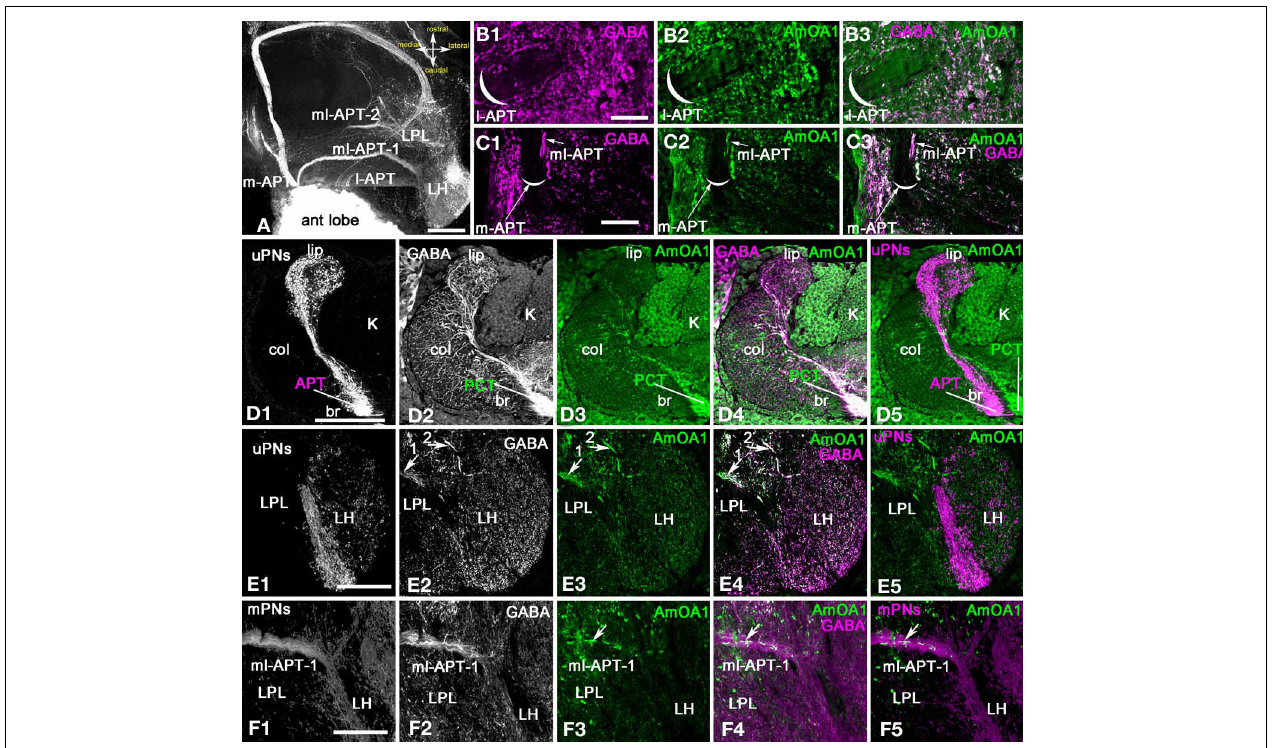
FIGURE 4 | Apis mellifera : The AmOA1 immunostainings in the central brain neuropils (LPL, PL, and MB calyx) are co-localized in the GABAergic neurons but not in uPNs. (A) An injection of a neurobiotin tracer into the antennal lobe revealed all antenna-protocerebral tracts (APTs). (B) The origin of l-APT tracts did not show GABA (magenta, B1 ) and AmOA1 (green, B2 ) staining inside of the tract. (B3) The merged image shows white fibers indicating the co-localization of anti-GABA and Anti-AmOA1 in the area surrounded the l-APT. (C) The beginning of the m-APT in a frontal section of the brain in which the anti-GABA ( C1 , magenta) and anti-AmOA1 ( C2 , green) are co-localized in the lateral part of the tract (white image merge in C3 ). The medial part of the m-APT containing axons from uPNs is not GABAergic. (D) The calyx of the MB on the frontal section of the brain with injected subsets of uPNs from l-APT and m-APT ( D1 , single image) stained with anti-GABA ( D2 , single image), and anti-AmOA1 ( D3 , single image). (D1) uPNs ending in the lip (lip) and basal ring (br) of the MB calyx. uPNs enter to the calyx via APT. (D2) Anti-GABA profiles originating from PCT (feedback) neurons that enter to the calyx via PCT (protocerebral tract) can be found in all calyxes. (D3) Anti-AmOA1 immunostained the Kenyon cell (K) as well as a subset of the